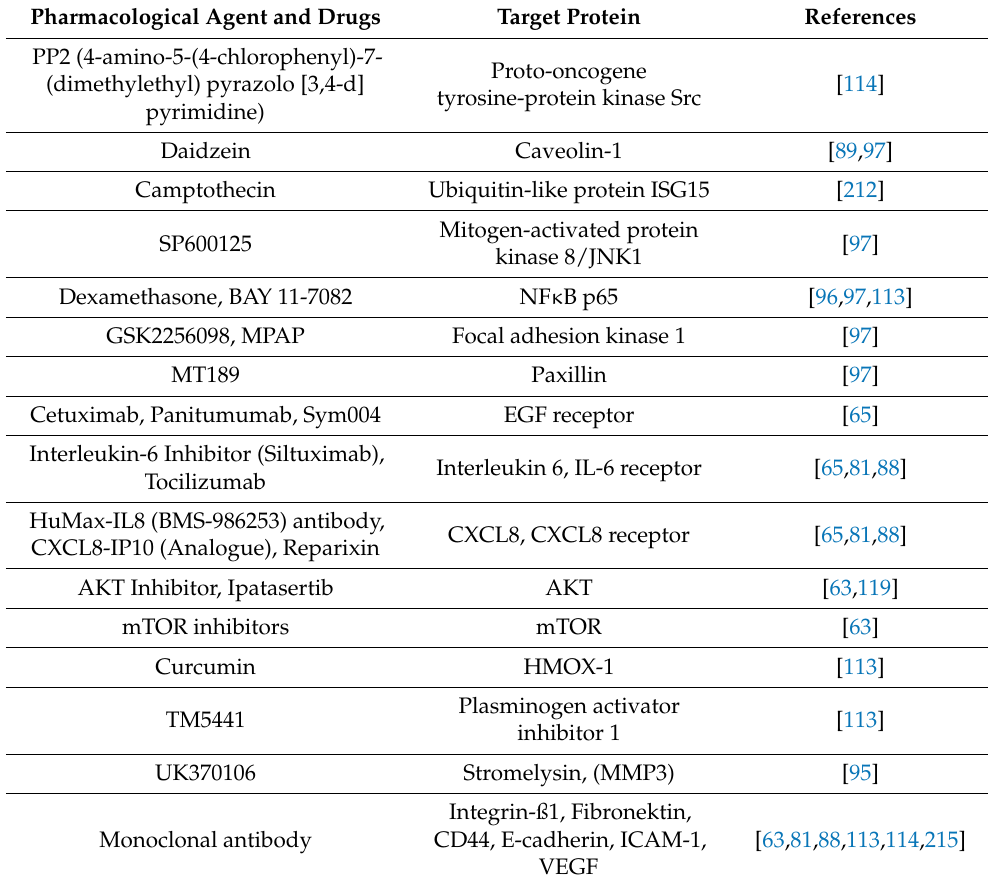
Table 5. Substances acting on the proteins detected in microgravity studies. Pharmacological Agent and Drugs Target